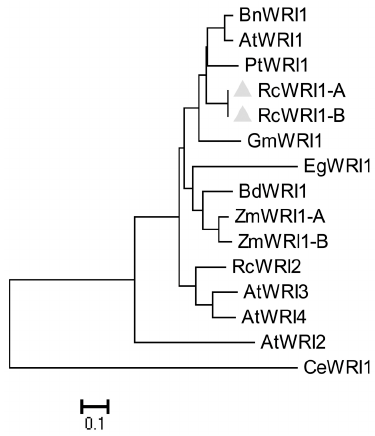
Figure 2. Phylogenic tree of RcWRI1s and WRI1 homologous from other plant species. Phylogenetic tree was generated using MEGA6 by the neighbor-joining method. Percentage values on each branch represent the corresponding bootstrap probability. Protein sequences used for phylogenic analysis included BnWRI1 (ADO16346), ZmWRI1-A (ACG32367.1), ZmWRI1-B(AIB05036.1), CeWRI1 (SRX1079431), PtWRI1 (XP_002311921.2), GmWRI1 (XP_006596986.1), BdWRI1 (Brai4g43877), AtWRI1 (AAP80382), AtWRI2 (ABG25074), AtWRI3 (NP_001320852.1), AtWRI4 (ABK32182.1), RcWRI2 (BAM75179.1) and EgWRI1 (AHX71676.1). The two RcWRI1s protein are highlighted by the grey arrowheads.